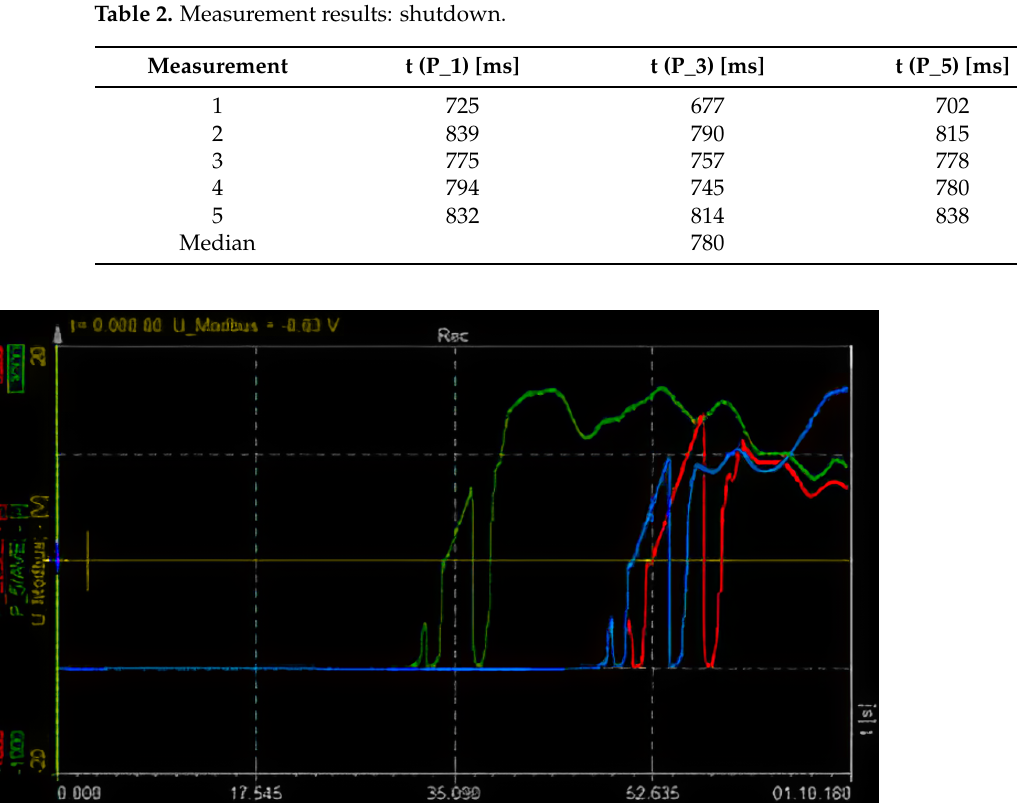
Figure 11. Startup for 3 phases